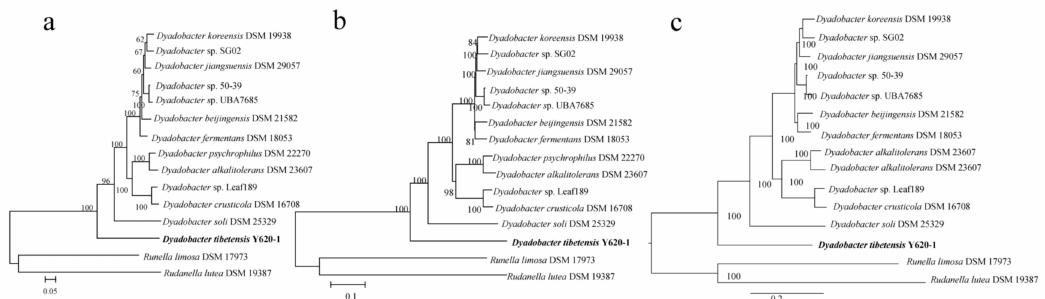
Figure 1. ( a ) Phylogenomic clustering of Dyadobacter strains based on concatenated alignment orthologous proteins using PhyloPhlAn; ( b ) Neighbor-Joining tree constructed by MEGA; ( c ) Bayesian tree constructed by Mrbayes. Numbers at nodes indicate bootstrap percentages for ML (Maximum Likelihood) and NJ (Neighbor Joining) tree, and posterior probabilities for Bayesian tree. Bar 0.05, 0.1 and 0.2 accumulated changes per amino acid for ML, NJ and Bayesian tree,